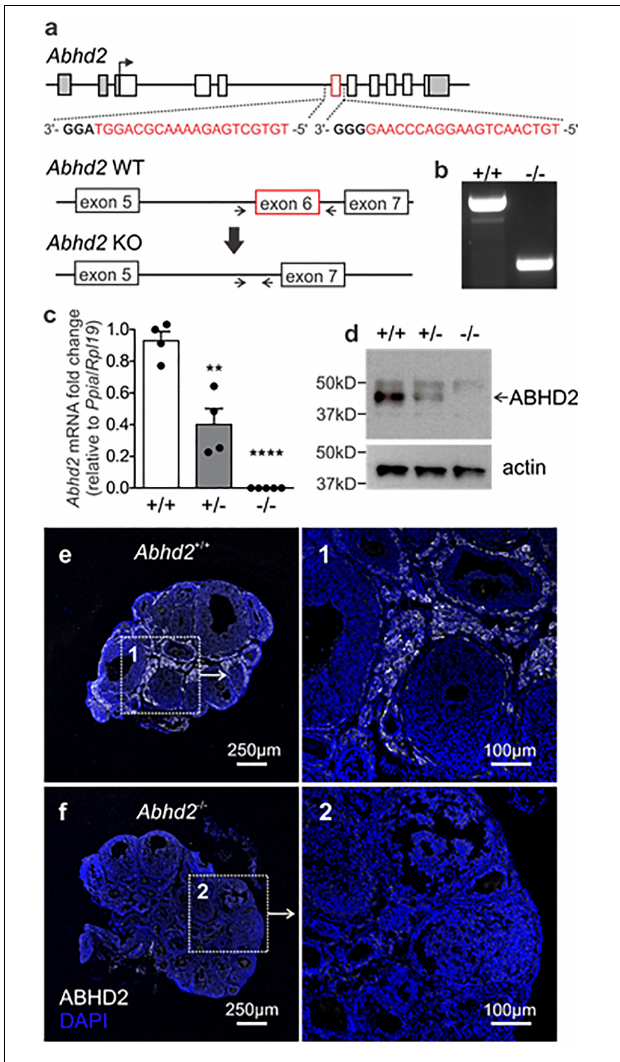
FIGURE 2 | Generation of the Abhd2 KO mouse line. (a) Schematic picture of the Mus musculus Abhd2 gene with untranslated regions marked in gray. Deletion of exon 6 (in red) was performed by CRISPR/Cas9, targeting sequences in the surrounding introns. The sequences of the two sgRNAs are labeled in red and the PAM sequence in bold. (b) Genotyping of mice was performed using primers that bind outside the deleted sequence (arrows). The PCR product from a wild-type mouse ( + / + ) contains the exon 6 sequence while the full KO (-/-) lacks Abhd2 exon 6. Abhd2 + / − mice show a significant reduction of Abhd2 expression in both (c) qPCR and (d) western blot studies while the full KO Abhd2 − / − completely lacks expression of exon 6 and the protein. Expression levels detected by qPCR were normalized to the expression of ribosomal protein L19 ( Rpl19 ) and peptidylprolyl isomerase A ( Ppia ). Statistical significance was calculated using the unpaired t -test and the significance of changes is indicated as follows: ** p ≤ 0.01; **** p ≤ 0.0001. Abhd2 + / + n = 4, Abhd2 + / − n = 4, and Abhd2 − / − n = 5. (e) The Abhd2 + / + mouse ovary shows ABHD2 in the stromal cells surrounding the follicles. (f) No protein staining was detected in the Abhd2 − / −